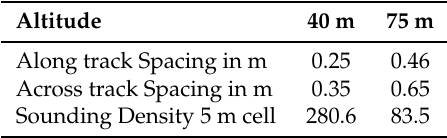
Table 17. Sounding distance along and across track for EM 2040 at 1.8 m/s forward velocity of the vessel.